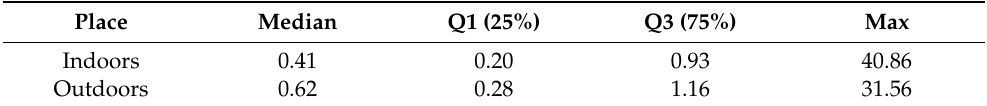
Table 5. Descriptive statistics parameters (median, 25th, and 75th percentiles, and maximum) for the E (V/m) values measured in indoor and outdoor places in